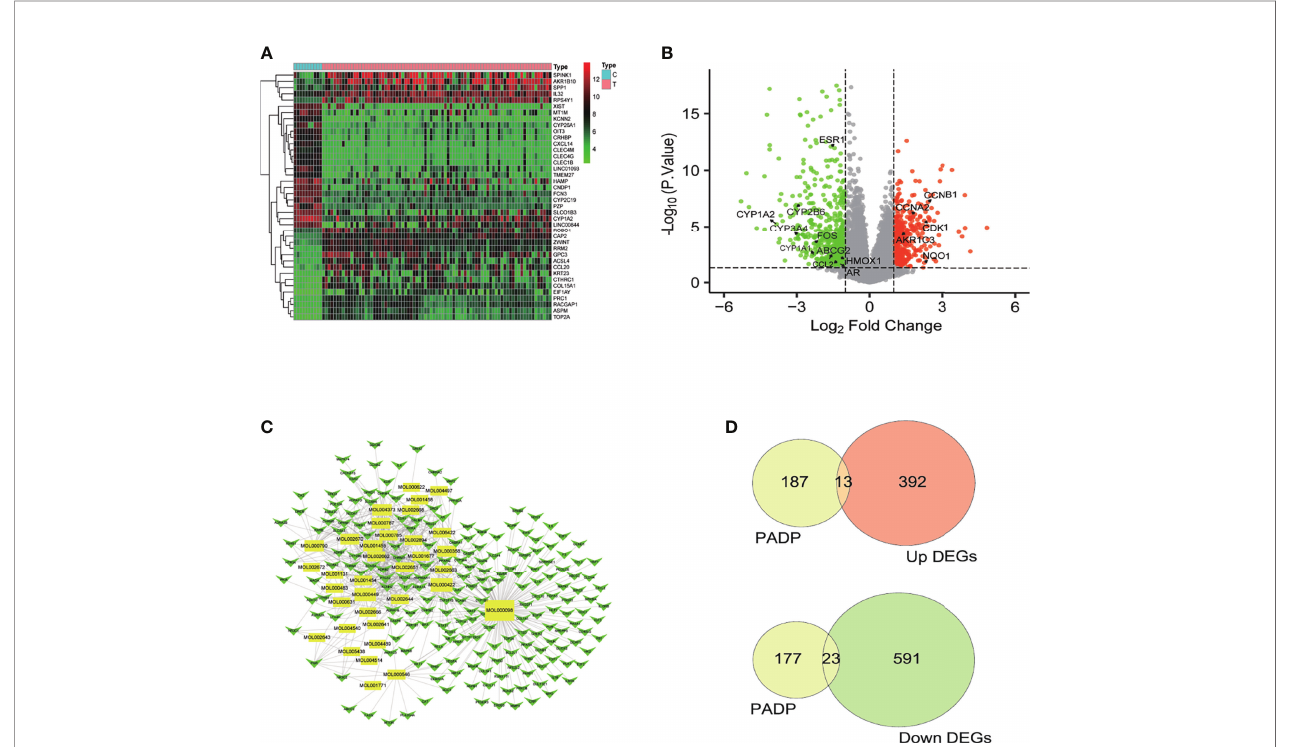
FIGURE 1 | The volcano and heat map of DEGs, compounds-targets network diagram and differential genes of liver cancer by PADP. (A) In the heat map, the abscissa represents the sample name, the ordinate represents the gene name, the light blue part represents the normal sample, and the pink part represents the tumor sample. The green part represents the low expression of the gene in the sample, the red part represents the high expression, and the black part is in between. (B) In the volcano diagram, the green part represents genes that are up-regulated in the normal group, the red part represents genes that are up-regulated in the tumor group, and the black parts represent genes that have no difference between the normal group and the tumor group. (C) The yellow rectangular nodes represent compounds, and the green arrows represent genes. The larger the graph area, the more adjacent nodes that represent the node, and the more important the node is. (D) Intersection of up-regulated and down-regulated differential genes of liver cancer by PADP.